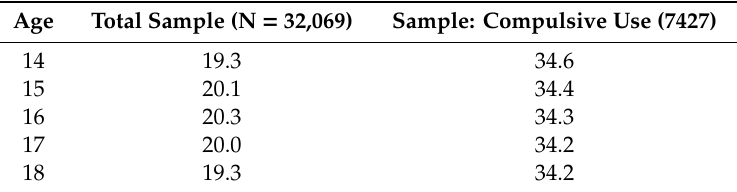
Table 5. Means on the CIUS scale by age.